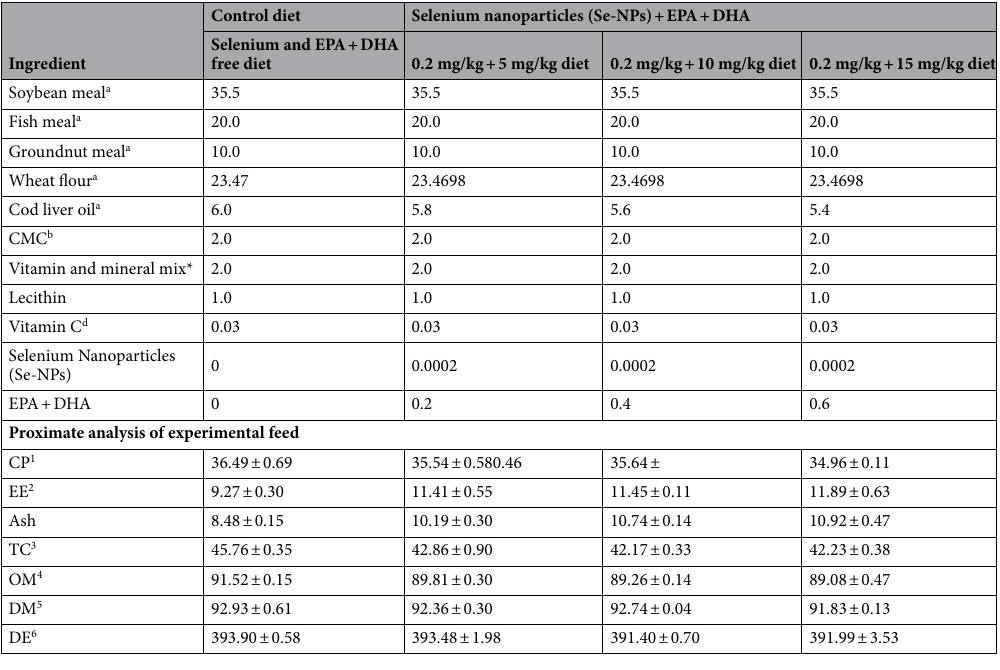
Table 1. Composition and proximate analysis of experimental diet (% dry matter) of selenium nanoparticles (Se-NPs), eicosapentaenoic acid (EPA) and docosahexaenoic acid (DHA) fed to Pangasianodon hypophthalmus during the experimental period of 105 days. CP 1 —crude protein; EE 2 —ether extract; TC 3 —total carbohydrate; OM 4 —organic matter, DM 5 —dry matter, DE 6 —digestible energy. Digestible energy (DE) (Kcal/100 g) = (%